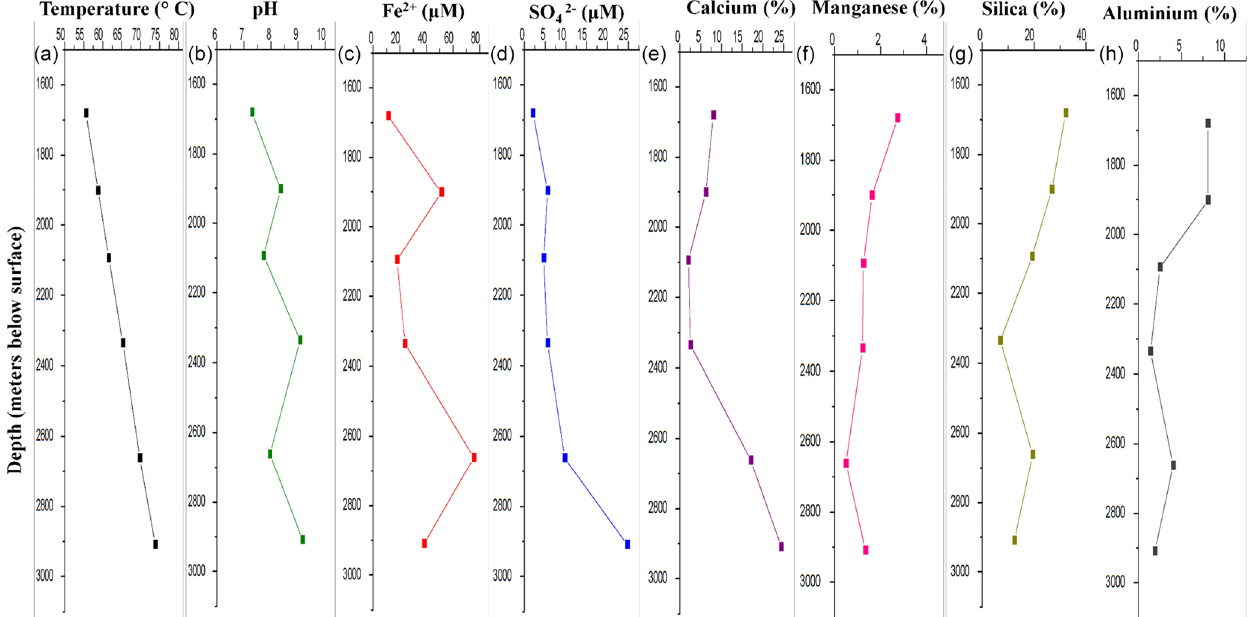
Figure 1. Major geochemical parameters of DF samples. There was a distinct variation in the geochemistry of DF samples obtained at different depths. Increase in temperature (a) , alkalinity (b) , iron (c) , sulfate (d) and calcium (e) was observed whereas the concentration of manganese (f) , silica (g) and aluminium (h) showed a decreasing trend.